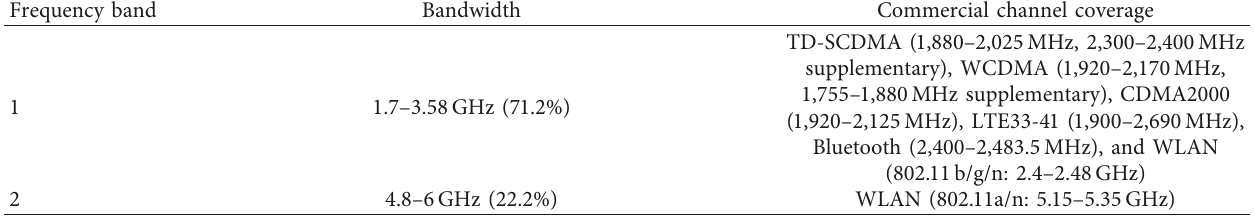
Table 2: Frequency bands covered by the antenna.